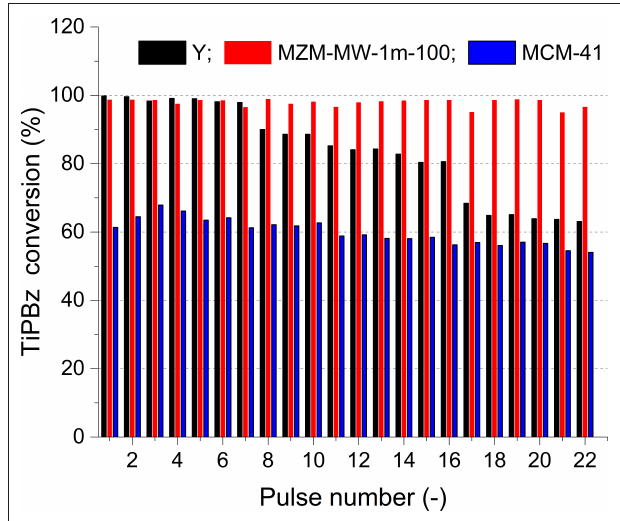
FIGURE 6 | Conversion of TiPBz over the parent Y zeolite, MZM-MW-1m-100, and MCM-41 as a function of pulse